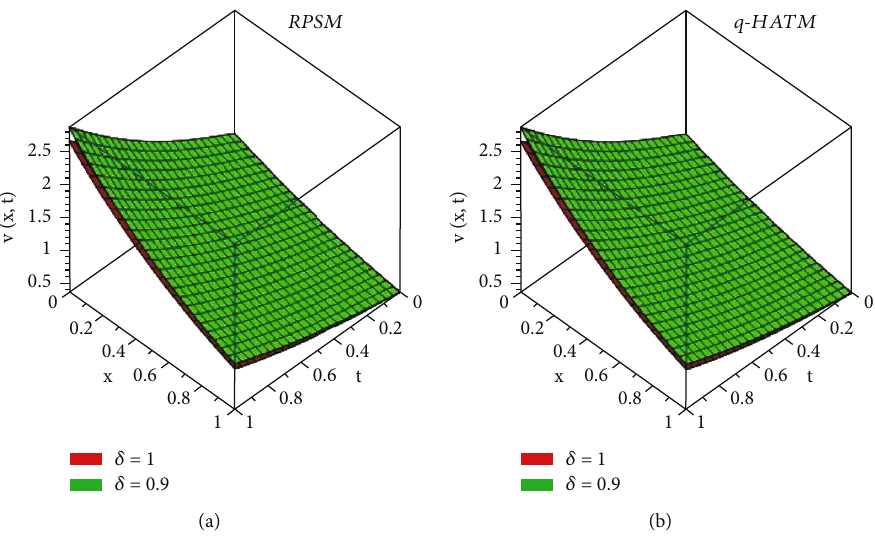
Figure 3: The 3D plots of example 4.1 for fractional order δ = 1,0 : 9 : Table 1: Solution comparison of RPSM, q-HATM, and Exact with di ff erent time and spaces of Example